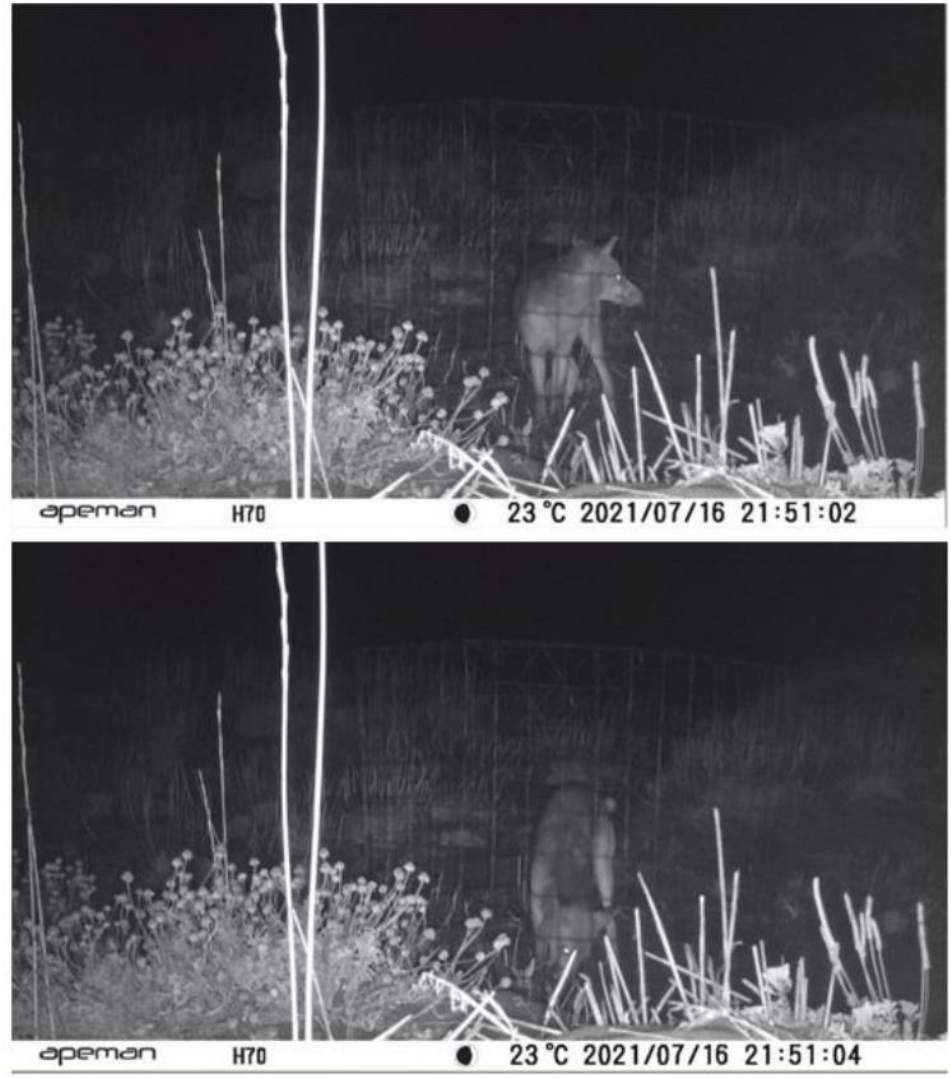
Figure 3. Fox ( Vulpes vulpes ) predating quail eggs in false nest after overcoming the cage (Photo: S. Vanadia by ApemanH70 photocamera).